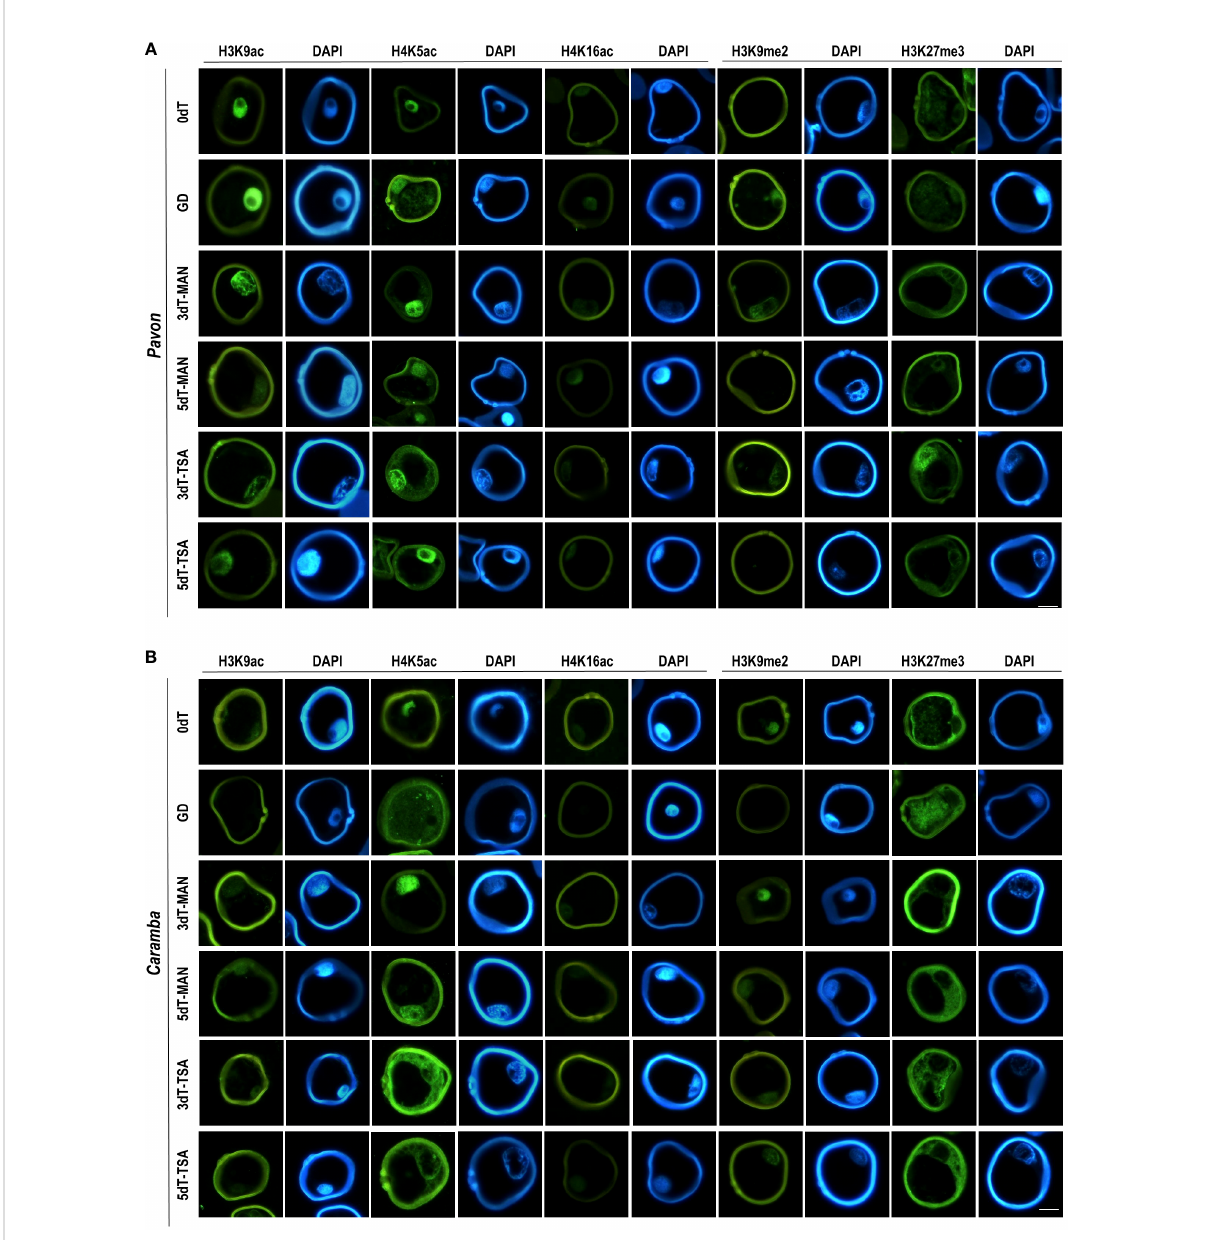
FIGURE 3 Immunolocalization of histone PTMs in microspores before stress treatment (0dT), microspores under gametophytic development (GD), microspores after 3 and 5 days with mannitol treatment (3dT-MAN, 5dT-MAN) and after 3 and 5 days with mannitol plus TSA treatment (3dT- TSA, 5dT-TSA) from Pavon (A) and Caramba (B) . H3K9ac, H4K5ac, H4K16ac, H3K9me2 and H3K27me3 antibodies labeling in green, DAPI in blue. Scale bar = 20